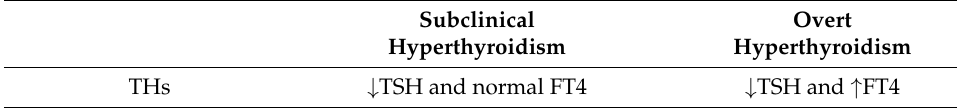
Table 2. Main differences between subclinical and overt